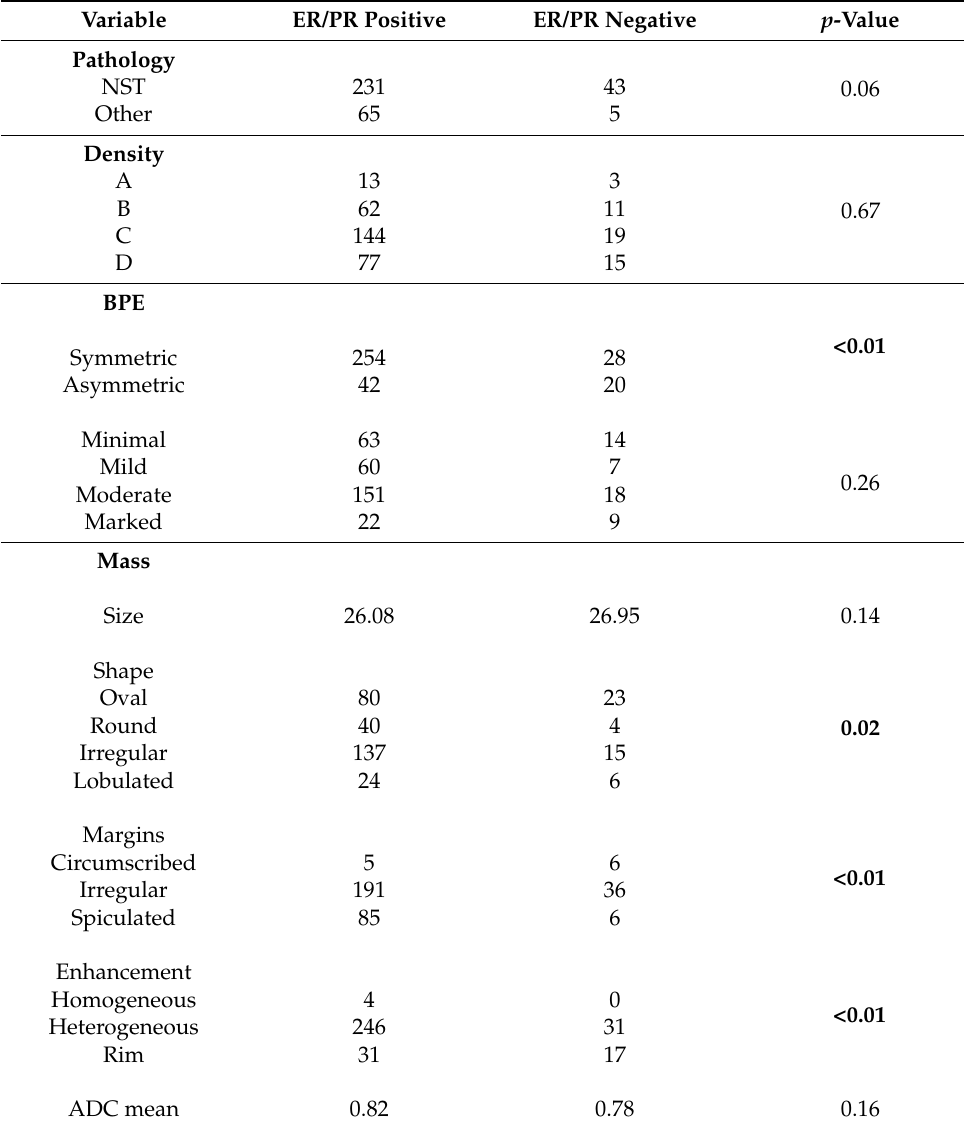
Table 4. ER/PR positive and ER/PR negative cancers in association with MRI